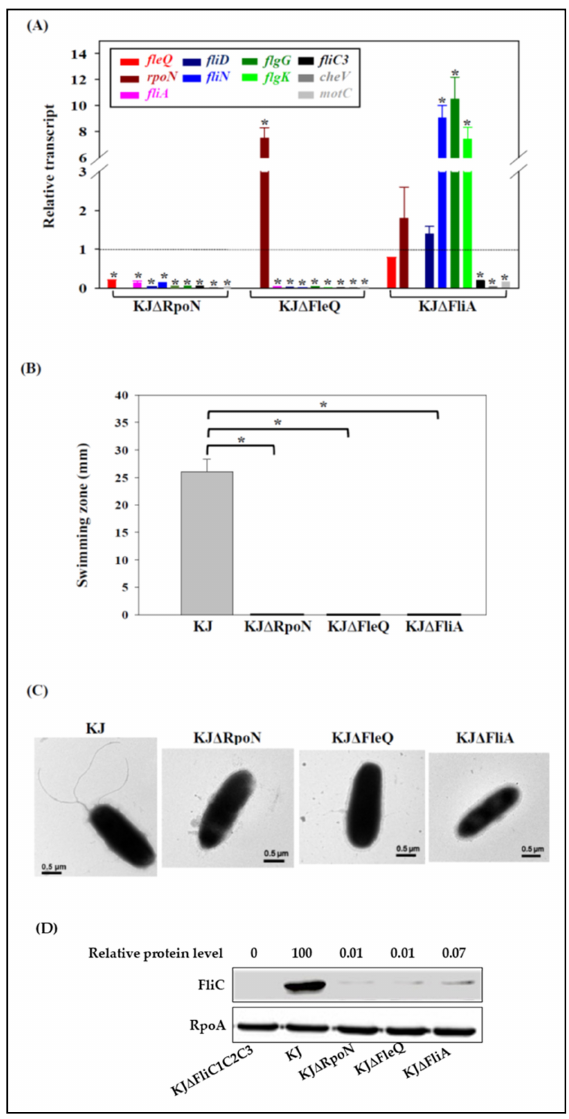
Figure 4. Impact of rpoN , fleQ , and fliA on flagellum-associated gene expression, swimming motility, flagellum morphology, and flagellin protein levels. ( A ) The impact of rpoN , fleQ , and fliA on flagellum- associated gene expression. Overnighted cultured bacterial cells (KJ, KJ ∆ RpoN, KJ ∆ FleQ, and KJ ∆ FliA) were inoculated into fresh LB broth and then grown for 5 h before a qRT-PCR. The expression levels of the assayed genes were normalized to those of the 16 S ribosomal RNA gene. The relative transcript was calculated by dividing the mRNA levels of the wild-type by those of the mutant indicated. The mean and SD of the three independent experiments are shown. *, a relative transcript greater than 2 or less than 0.5 was considered to be significant. ( B ) The impact of rpoN , fleQ , and fliA on swimming motility. Overnighted cultured bacterial cells were inoculated into fresh LB broth and then grown for 5 h before testing. A five-microliter bacterial cell suspension was inoculated into swimming agar and then incubated at 37 ◦ C for 48 h. The swimming zones were recorded. The data are the means of three independent experiments. The error bars indicate the standard deviations of three triplicate samples. *, p < 0.05, significance calculated using the Student’s t -test. ( C ) The impact of rpoN , fleQ , and fliA on flagella morphology. The flagella were negatively stained with 1% phosphotungstic acid (pH 7.4) and observed using TEM. ( D ) The impact of rpoN , fleQ , and fliA on flagellin protein levels. The proteins of a whole-cell extract were separated using SDS-PAGE and immunoblotting with anti-FliC3 and anti-RpoA